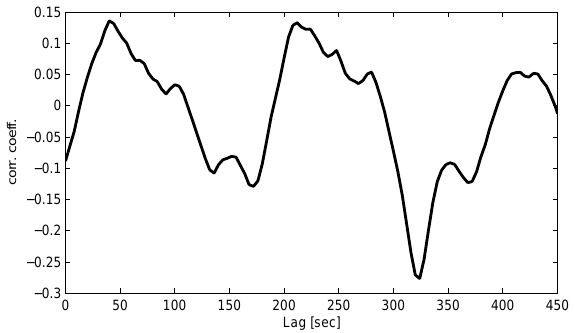
Fig. 7. The correlation coefficient between C3 and C4 proton fluxes as a function of the lag between the signals. The time interval is the same as in Fig. 5, i.e., 22:50 to 23:30 UT. Positive lags correspond to shifting of C4 signal forward in